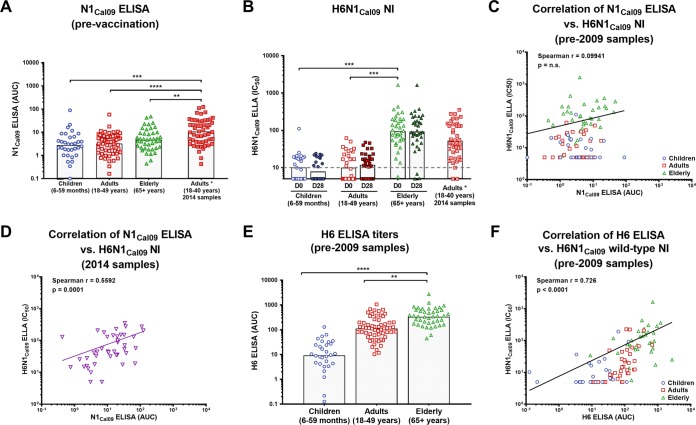
Binding and functionality of antibodies against the 2009 pandemic H1N1 NA. (A) Geometric mean Cal09 N1 ELISA titers (AUC) of sera from children, adults, and the elderly (prepandemic) and sera from adults collected after the 2009 pandemic. The postpandemic adult sera had significantly higher Cal09 N1 ELISA titers than the sera from the three age groups that were not exposed to the 2009 pandemic virus. (B) Mean ELLA titers against the H6N1Cal09 virus before and after vaccination. The dashed line indicates the starting serum dilutions used in the ELLA assays. (C) The Ella IC50 H6N1Cal09 values and the Cal09 N1 ELISA titers in sera from individuals not exposed to the 2009 pandemic H1N1 virus do not correlate (Spearman r = 0.09914). n.s., not significant. (D) Titers from postpandemic sera do correlate well (Spearman r = 0.5592, P = 0.0001). (E) Mean H6 HA ELISA titers of the prepandemic cohort (children, adults, and the elderly; collected on day 0). The elderly had high baseline titers compared to children and adults. (F) The ELLA IC50s for H6N1Cal09 correlate well with the ELISA titers measured against H6 for individuals not exposed to 2009 H1N1 pandemic virus (Spearman r = 0.726, P < 0.0001).